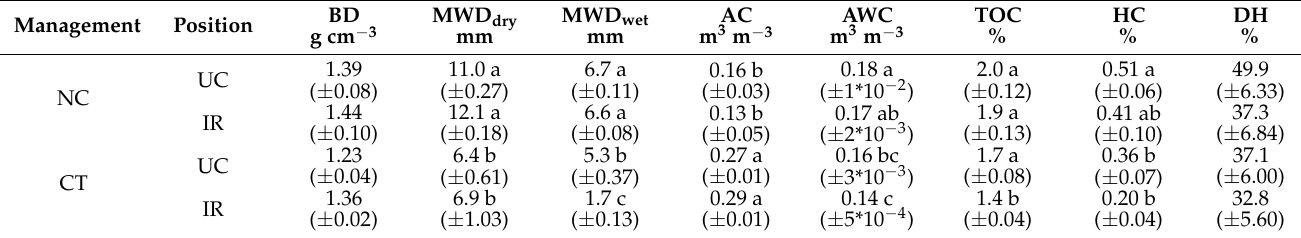
Table 2. Soil physical and chemical properties * under different management systems (NC and CT) and positions (UC and